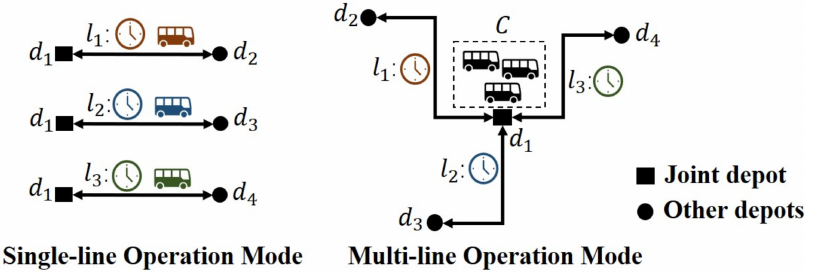
Figure 2. A schematic diagram of different operation modes.